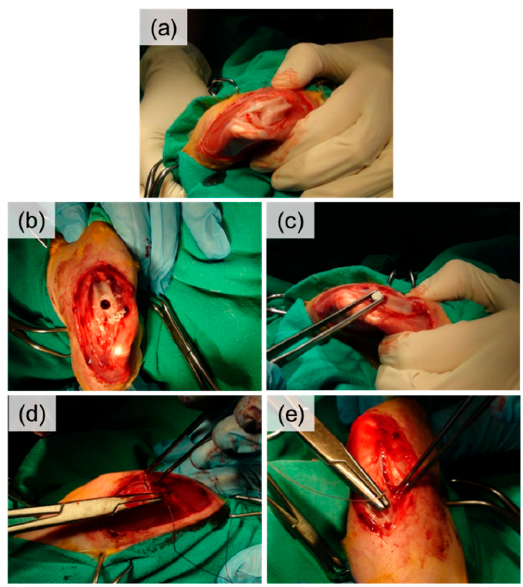
Figure 8. Surgical procedure of sca ff old implantation into rabbit femoral trochlear: ( a )—exposed surface of femoral trochlear, ( b )—hole drilled in the trochlear groove, ( c )—sca ff old introduction, ( d )—tissues apposed with absorbable sutures, ( e )—skin apposed with non-absorbable sutures. To alleviate postoperative pain, rabbits were given an anti-pain drug (butorphanol at a dose of 0.1 mg / kg) and an anti-inflammatory drug (Sul-Tridin 24% at a dose of 30 mg / kg once a day for five